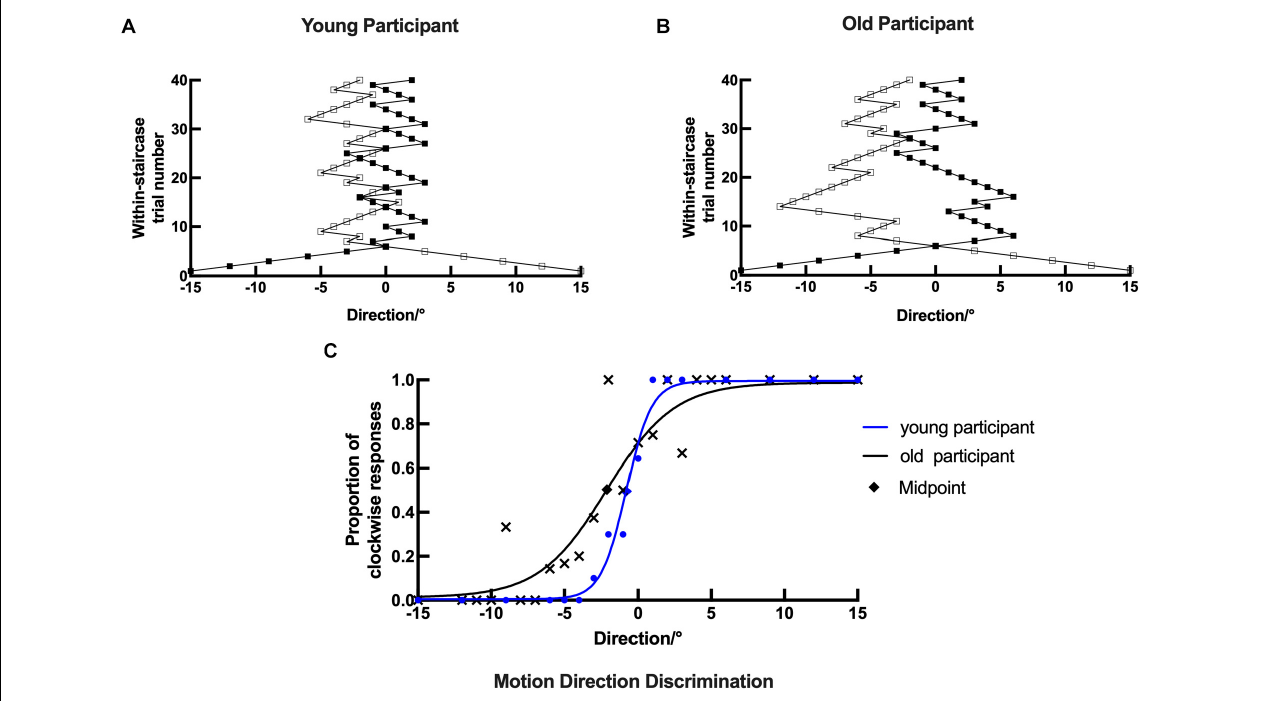
FIGURE 6 | Example plots of a young participant and an old participant showing the raw data analysis in the motion direction task. ( A,B , respectively) Examples of the staircase plots showing the within-staircase trail number versus the motion direction angles for a young participant and an old participant. Open symbols are for convergence point of 25%, and filled symbols are for convergence points of 75%. The negative angles represent counterclockwise relative to the upward motion direction, and vice versa . (C) Examples of the plots showing the proportion of the clockwise responses versus the angles in motion direction and the respective psychometric function. The black X, rhombus shape, and curve (function parameters: l = 0.0124, µ = 2.1248, and σ = 3.8050) for an old participant. The blue dots, rhombus, and curve for a young participant (function parameters: l = 0.0049, µ = 0.7850, and σ = 0.4270). Rhombus is the midpoint of the curve.